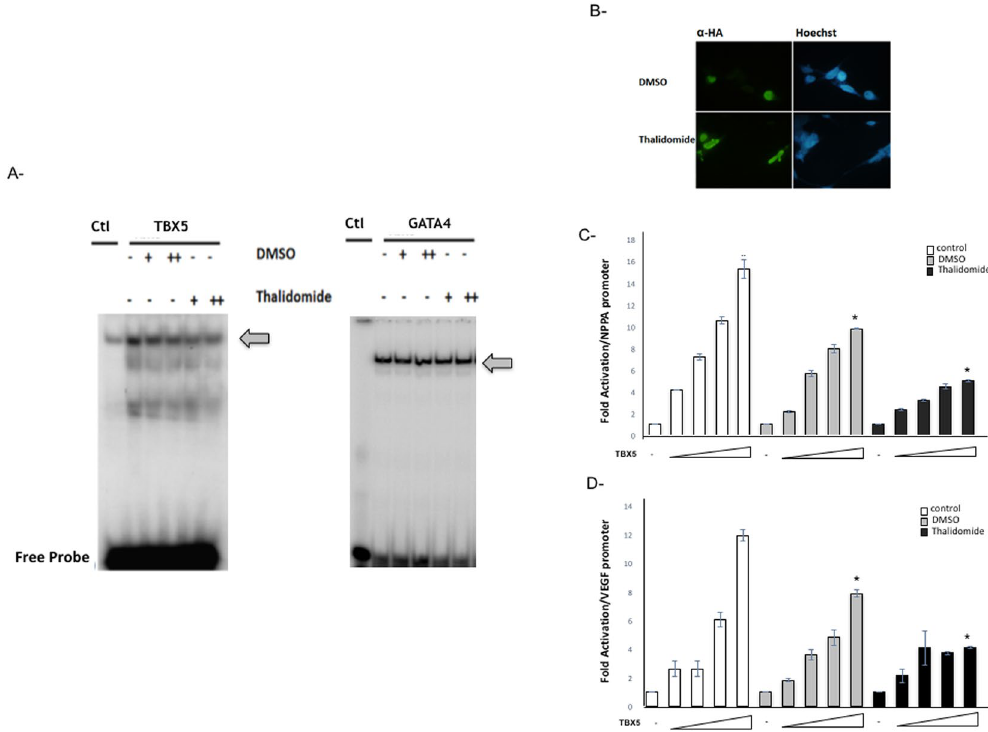
Figure 2. Thalidomide specific inhibition of TBX5 binding and activity. Interactions of TBX5 and GATA4 with the NPPA TBE and GATA sites was assessed by electrophoretic mobility shift assays using nuclear extracts from HEK293T cells overexpressing HA-TBX5 or Flag-GATA4 ( A ). The binding of TBX5 (arrow) is suppressed by 42% in the presence of 4 µ M of thalidomide, while that of GATA4 (arrow) was not affected. ( + 2 µ M, ++ 4 µ M). DMSO treatment was used as a negative control. Immunofluorescence of JR1 cells transfected with the plasmid overexpressing a HA-tagged TBX5 protein and then treated with either 4 µ M DMSO or thalidomide. The localization of TBX5 was visualized using an anti‐ HA antibody followed by a fluorescent secondary antibody ( B ). Nuclei of cells were visualized using the Hoechst dye (blue color). TBX5 showed nuclear localization (green color) in both conditions. (Magnification X40). Same results were obtained for Hela and Hek293 cells. Transcriptional activity was assessed by luciferase assay. Increasing doses of TBX5 (100 to 500 ng) were transiently co-transfected with the rat NPPA ( C ), or mouse VEGF ( D ) promoters coupled to luciferase in HEK293 cells. Treatment with thalidomide (4 µ M) or its equivalent amount of DMSO was done after 24 hours, and cells were harvested for luciferase assay. Relative luciferase activities are represented as fold changes. The data are the means of 3 independent experiments done in duplicates ± SE. Significance ( * P < 0.05) was assessed using the one‐way ANOVA